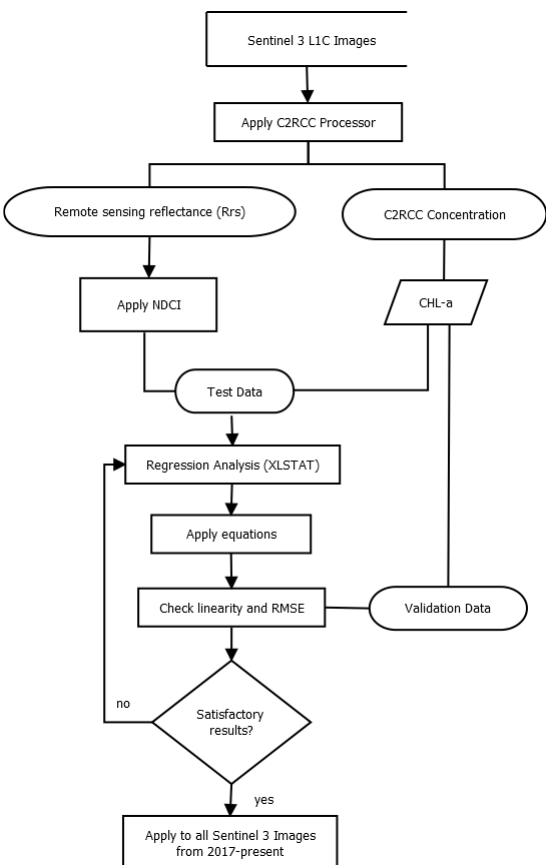
Figure 2. Workflow for development and application of the transformed NDCI